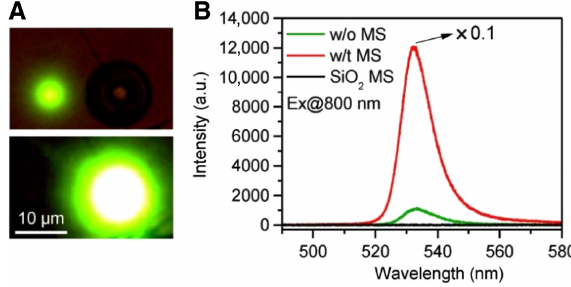
Figure 17: Enhanced 2PA-induced emission from a 2D perovskite- microsphere structure. (A) 2PL images of the perovskite flake without (top panel) and with (bottom panel) SiO microsphere under an excitation power of 2 0.1 mW, respectively. (B) 2PL spectra for a bare perovskite flake (w/o MS, green curve) and a perovskite-microsphere hybrid dielectric structure (w/t MS, red curve). The SiO microsphere shows no 2 emission within this waveband (black curve). Reprinted from